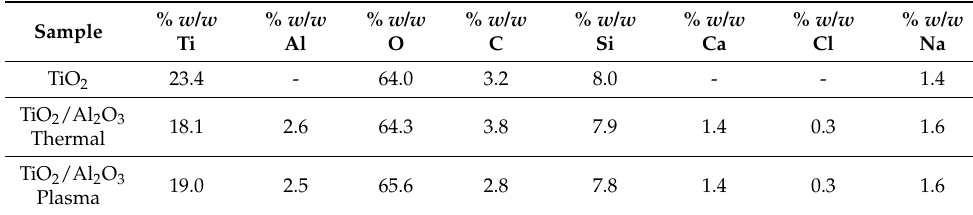
Table 2. EDX Compositional analysis of the samples.